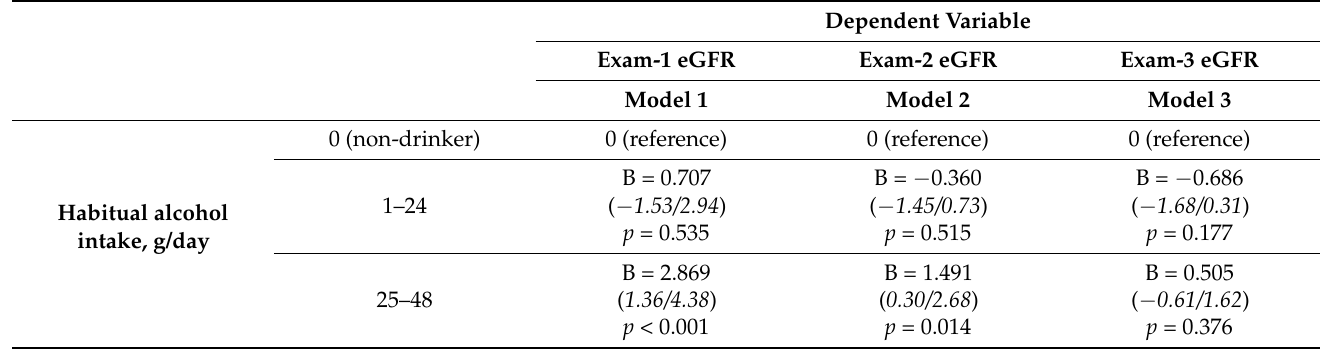
Figure 5. Cross-sectional analyses: mean and 95%CI of eGFR by stratum of alcohol intake (g/d = g/day) at Exam-1, Exam-2, and Exam-3 in non-adjusted ANOVA (black lines) and ANOVA adjusted for covariates (grey lines). Number of examinees per stratum is in Table 1. p -values are from ANOVA. Covariates in adjusted ANOVA for Exam-1 data: gender and data at Exam-1 for age, education, log-transformed urinary sodium/creatinine ratio, log-transformed urinary potas- sium/creatinine ratio, urinary creatinine, body mass index, systolic pressure, diastolic pressure, anti- hypertensive drug treatment, serum total cholesterol, smoking, and diabetes. Covariates in adjusted ANOVA for Exam-2 data: gender and data at Exam-2 for age, education, log-transformed urinary sodium/creatinine ratio, log-transformed urinary potassium/creatinine ratio, log-transformed uri- nary urea nitrogen/creatinine ratio, urinary creatinine, body mass index, systolic pressure, diastolic pressure, antihypertensive drug treatment, serum total cholesterol, smoking, and diabetes. Covari- ates in adjusted ANOVA for Exam-3 data: gender and data at Exam-3 for age, education, urinary creatinine, body mass index, systolic pressure, diastolic pressure, antihypertensive drug treatment, serum total cholesterol, smoking, and diabetes. Table 3. Cross-sectional analysis: multi-variable linear regression models for data of Exam-1, Exam-2, and Exam-3 with eGFR regressed over stratum of alcohol